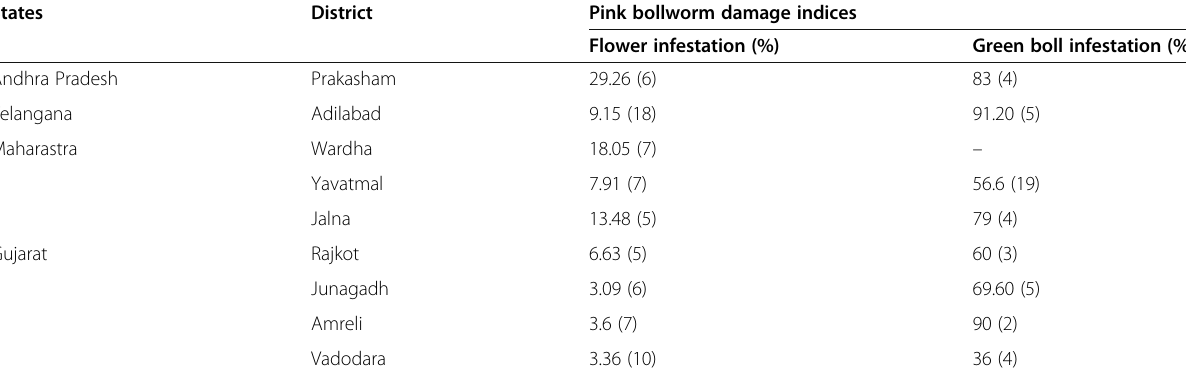
Table 1 Infestation of Pectinophora gossypiella on flowers and green bolls of Bacillus thuringiensis cotton in India States District Pink bollworm damage indices Flower infestation (%) Green boll infestation